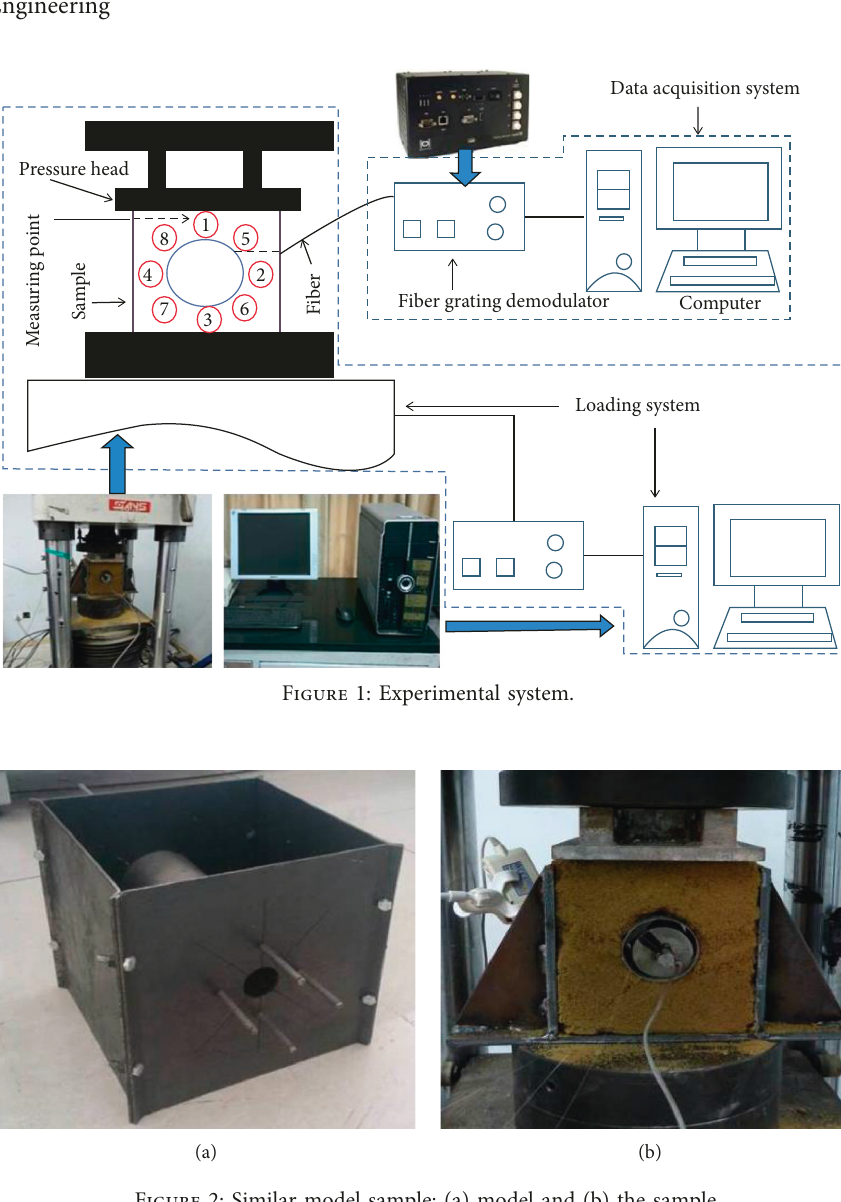
Figure 2: Similar model sample: (a) model and (b) the sample.